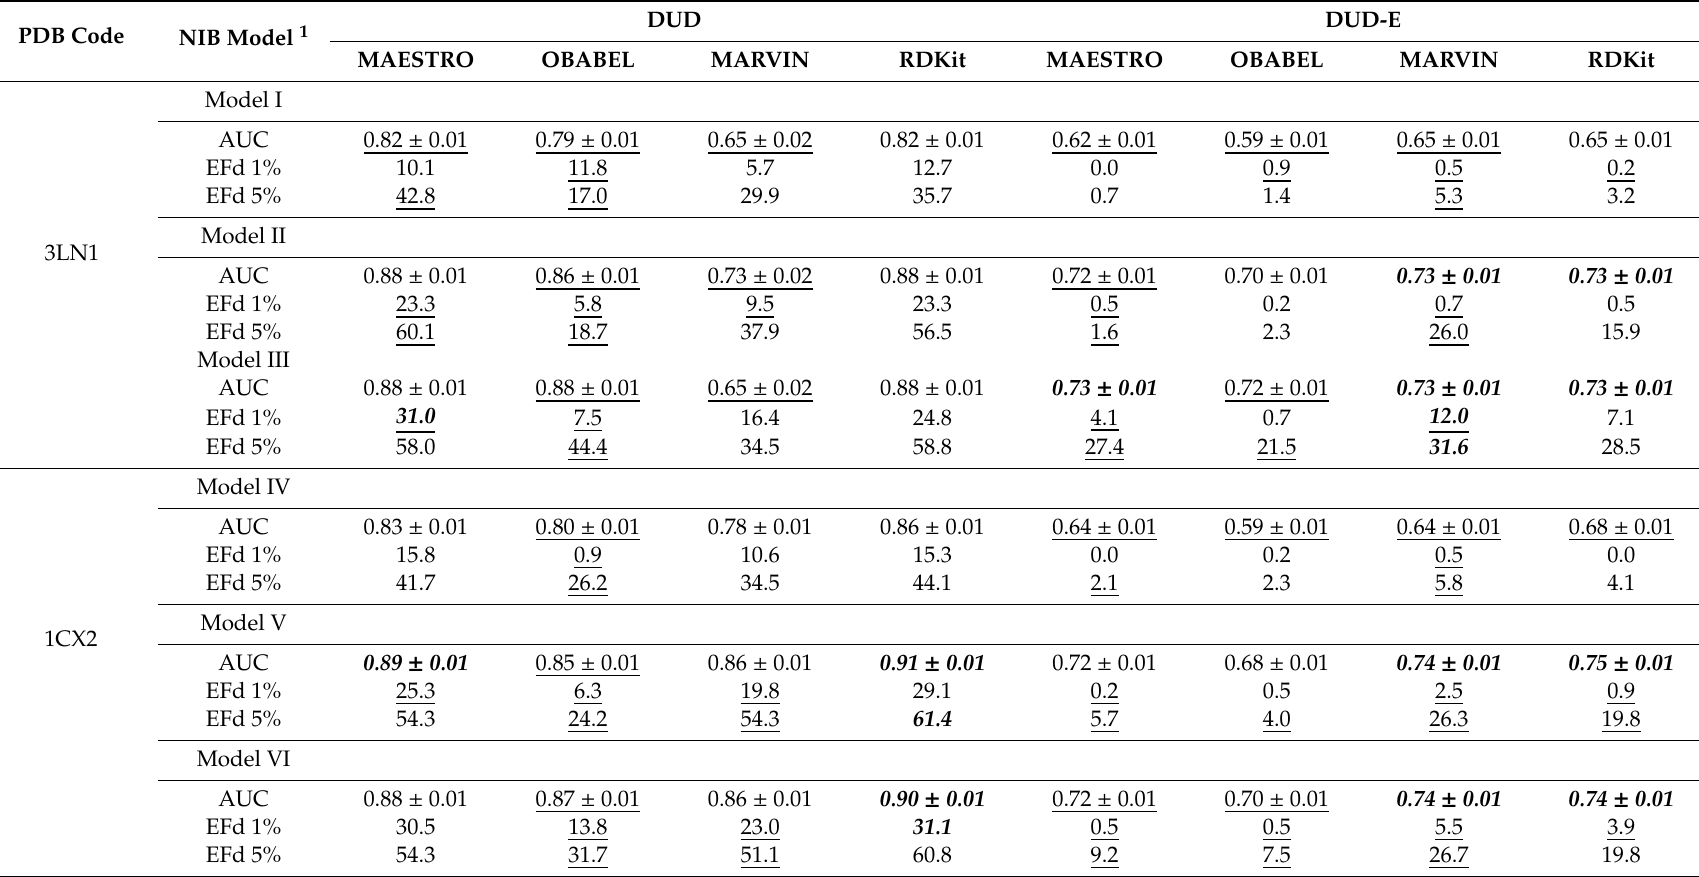
Table 2. Negative image-based screening using the single low-energy